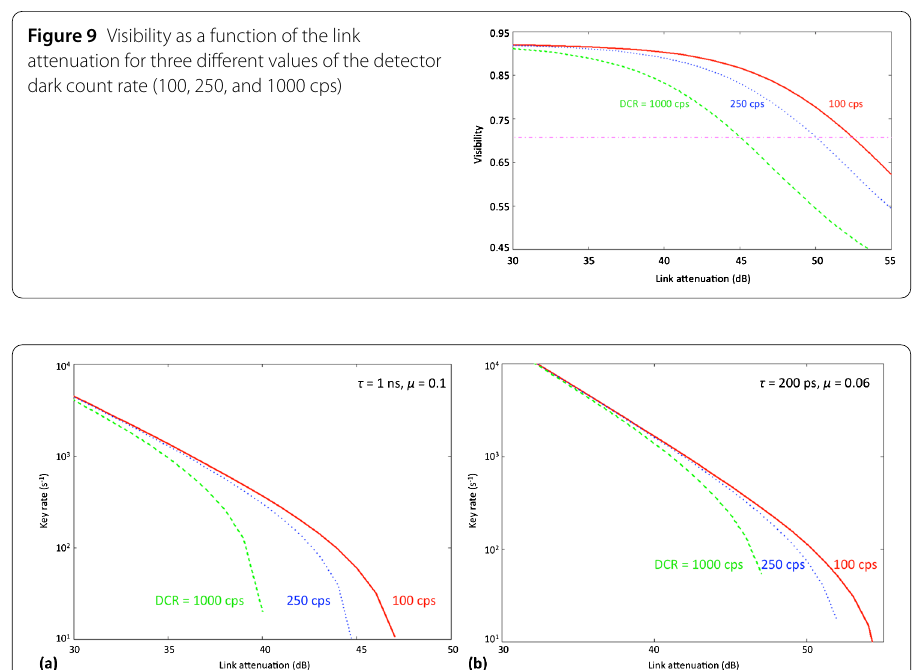
Figure 10 The secure secret key rate for three different values of the dark count rate as a function of the link attenuation (solid curve: 100 cps; dotted curve: 250 cps; dashed curve: 1000 cps per detector). ( a ) For the conservative parameters of Table 3 and τ = 1 ns and μ = 0.1 ( R pair = 10 8 s –1 ), ( b ) same, except for τ = 200 ps and μ = 0.06 ( R pair = 3 · 10 8 s –1